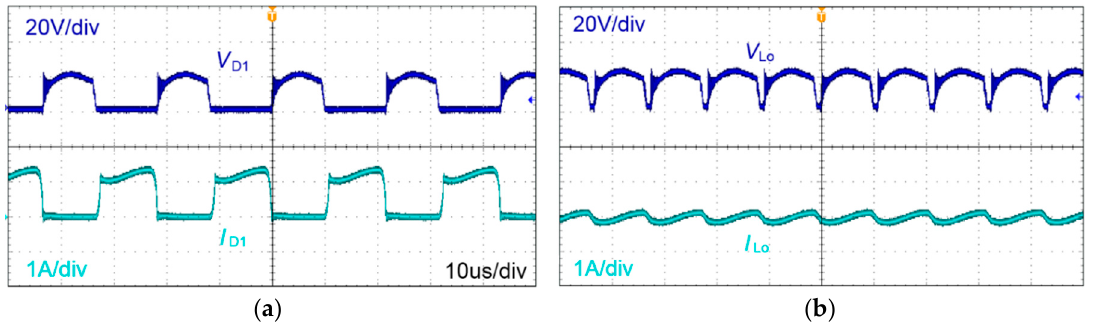
Figure 10. The dynamic voltage and current waveforms of the output diode ( a ) and the inductor ( b ).